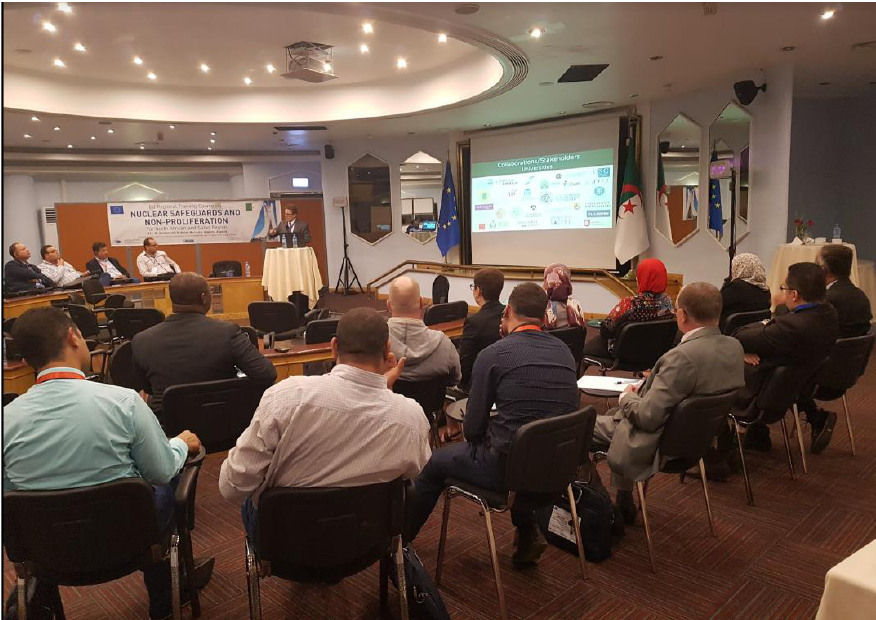
Figure 5: A lecture session of the ESARDA Course in Algiers, October